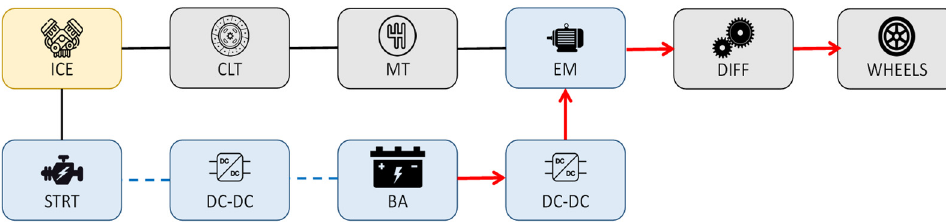
Figure 8. Energy fluxes in pure electric mode.